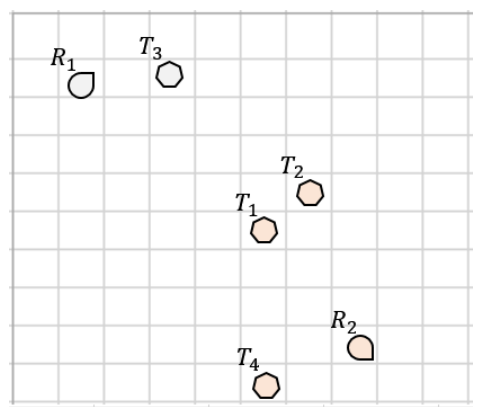
Figure 2. Synergy example: the optimal assignment is to assign T 3 to robot R 1 and T 4 to robot R 2 because they have negative synergy. Because T 1 and T 2 have positive synergy, they must be performed by one robot, R 2